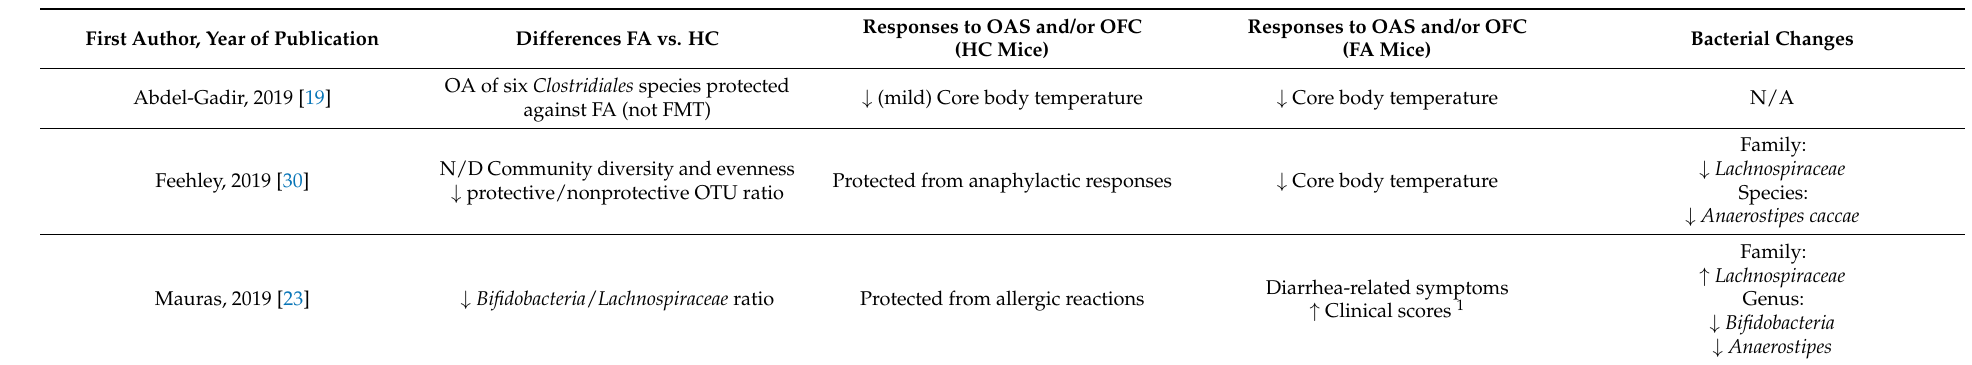
Table 5. Results from studies exploring changes in gut microbiota and/or allergic symptoms after fecal microbiota transplantation in mice receiving microbiota from a donor with food allergies or a healthy